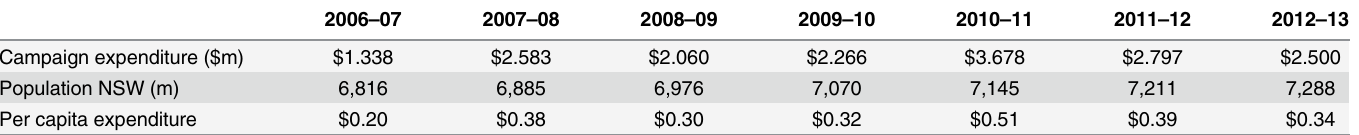
Table 4. Cost of CINSW public education mass media campaigns, 2006 – 07 to 2012 – 13 (constant 2010 – 11